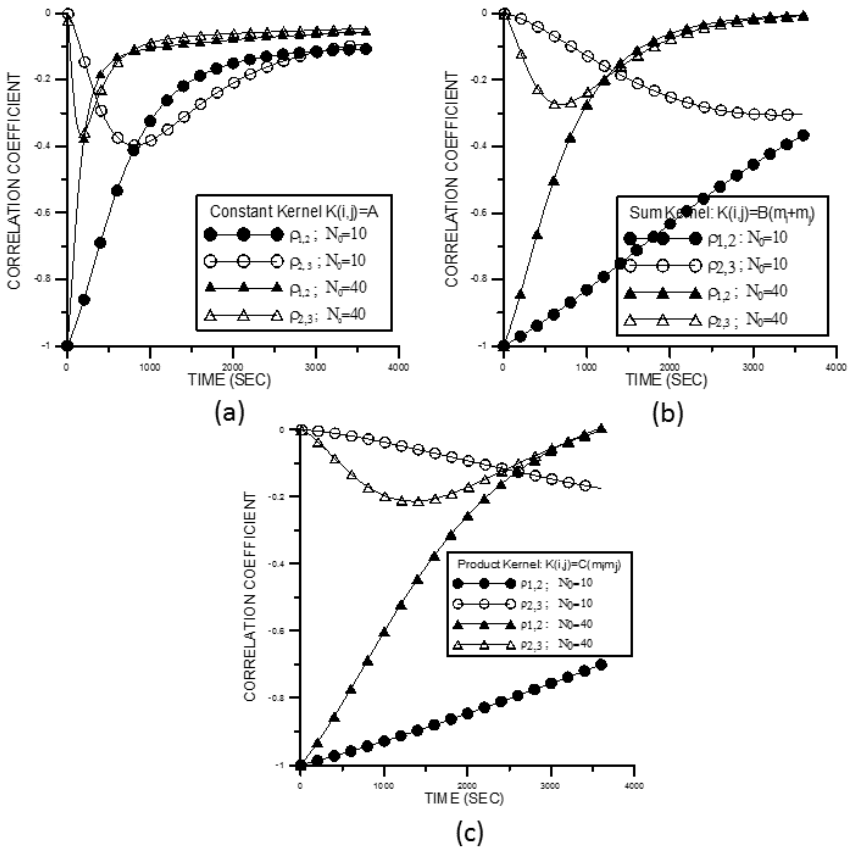
Figure 6. Time evolution of the correlation coefficients ρ 1 , 2 and ρ 2 , 3 for the constant, sum and product kernels (in panels a , b and c , respectively) for two systems with a volume of 1cm − 3 and containing 10 and 40 droplets of